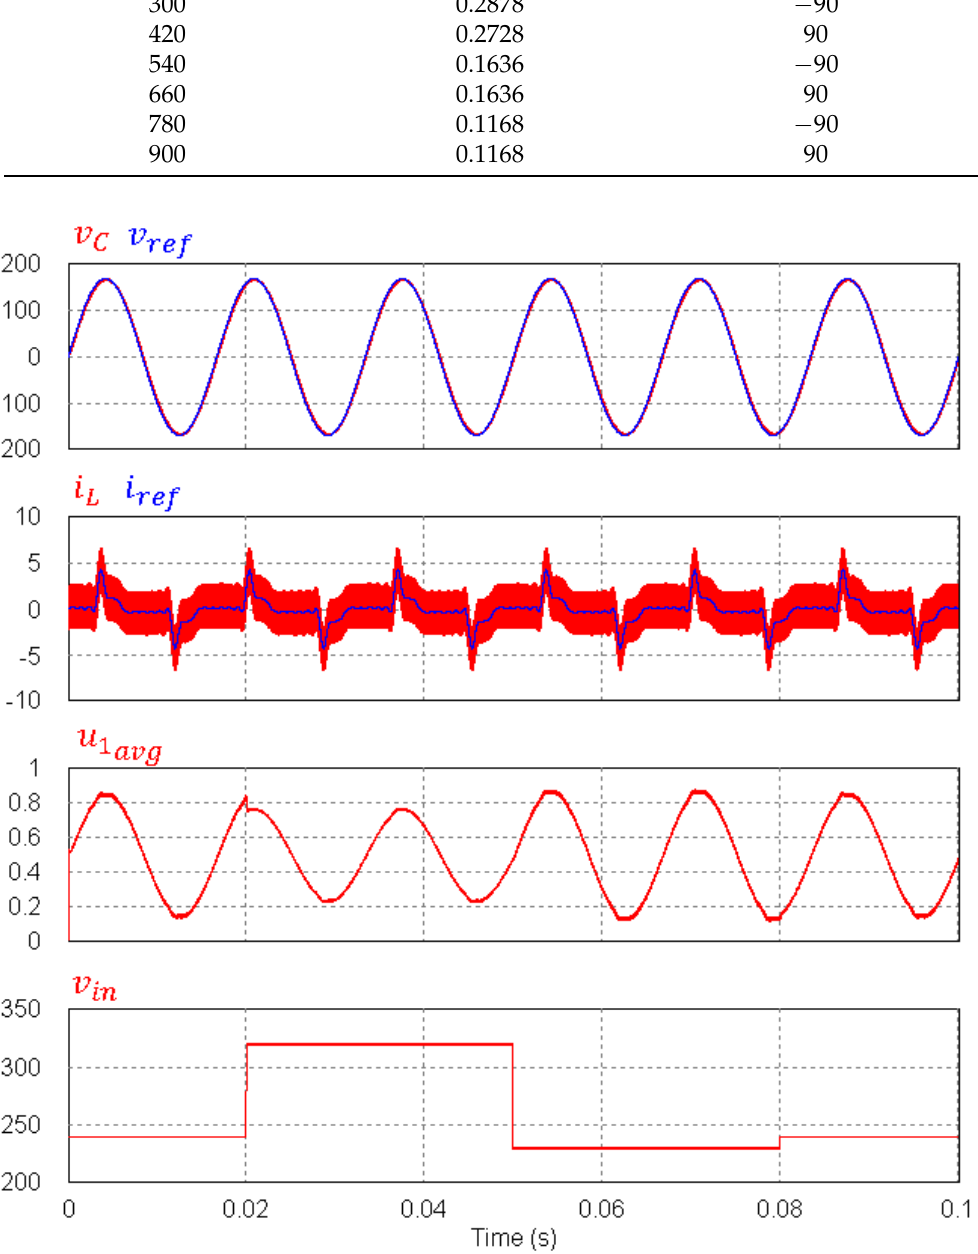
Figure 4. Simulated waveforms of the full-bridge inverter feeding a CFL-type nonlinear